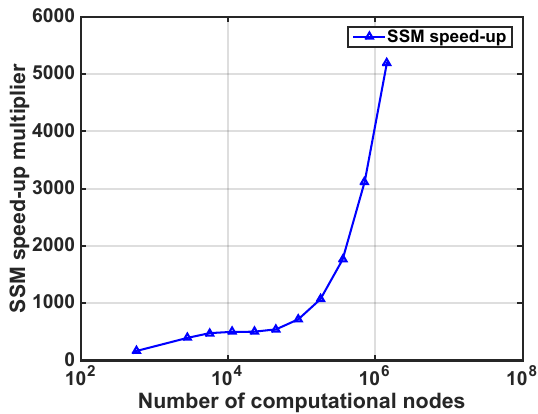
Figure 4. Speed-up multiplier of SSM compared to PTM for Case 4 as a function of the number of computational